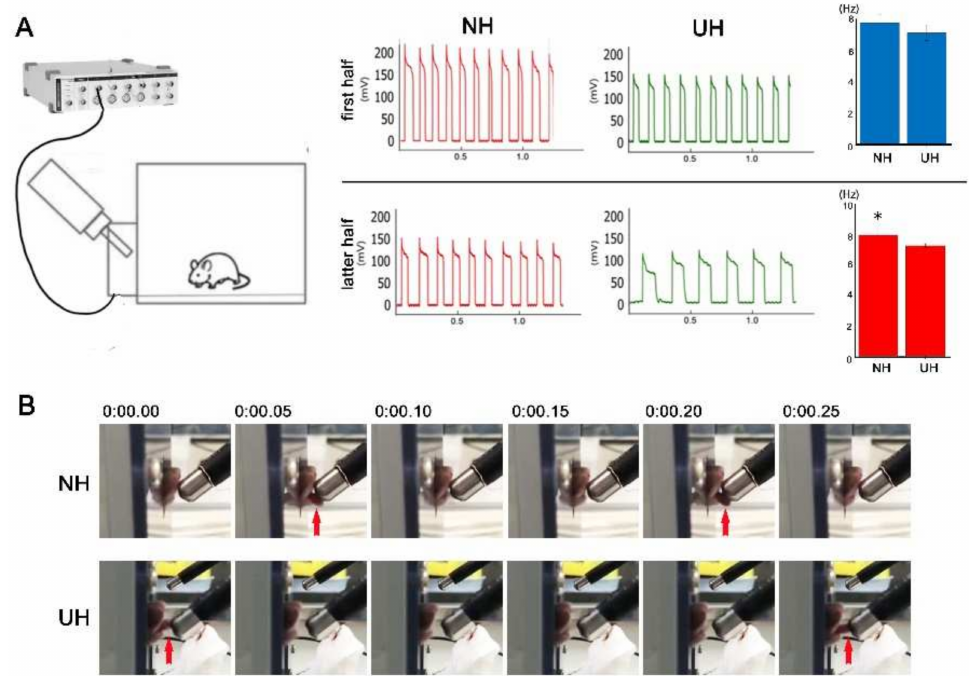
Figure 3. Lapping behavior in mice: ( A ) Electrophysiological single units during lapping behavior. Autocorrelogram of the lapping events revealed the temporally precise rhythmicity of the behavior at a periodicity of approximately 8 Hz. The upper row presents the first half, and the lower row presents the second half. Lapping counts in the second half were smaller in the tooth loss (UH) group than in the non-extraction control (NH) group (* p < 0.05). ( B ) Tongue movement during lapping behavior. Recorded tongue movements revealed that NH mice protruded their tongues anteroinferiorly, whereas UH mice protruded their tongues